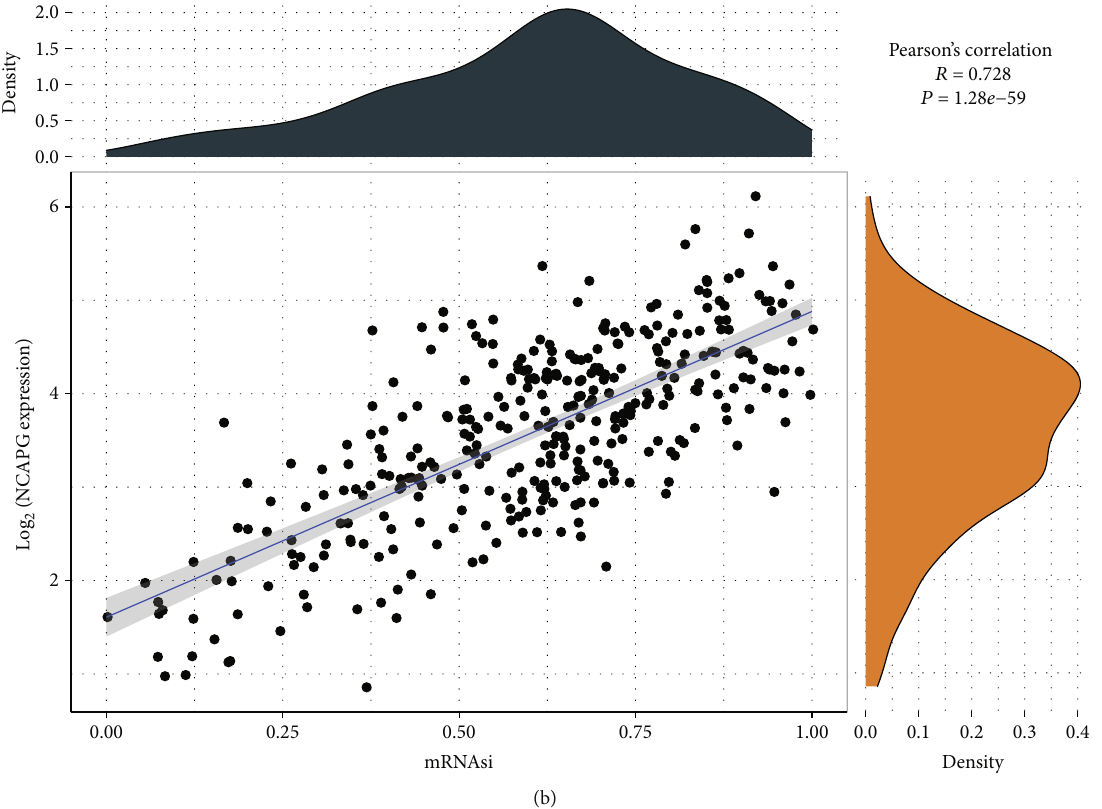
Figure 10: The relation between risk score and tumor stemness. (a) Comparison of tumor stemness (mRNAsi) between high- and low-risk groups in GSE66229, TCGA, GSE84437, GSE26942, GSE13861, GSE28541, and GSE26253 datasets. Student ’ s t -test was conducted. (b) Pearson correlation analysis between NCAPG expression and mRNAsi. ns: not signi fi cant. ∗∗∗ P < 0 : 001 and ∗∗∗∗ P < 0 : 0001